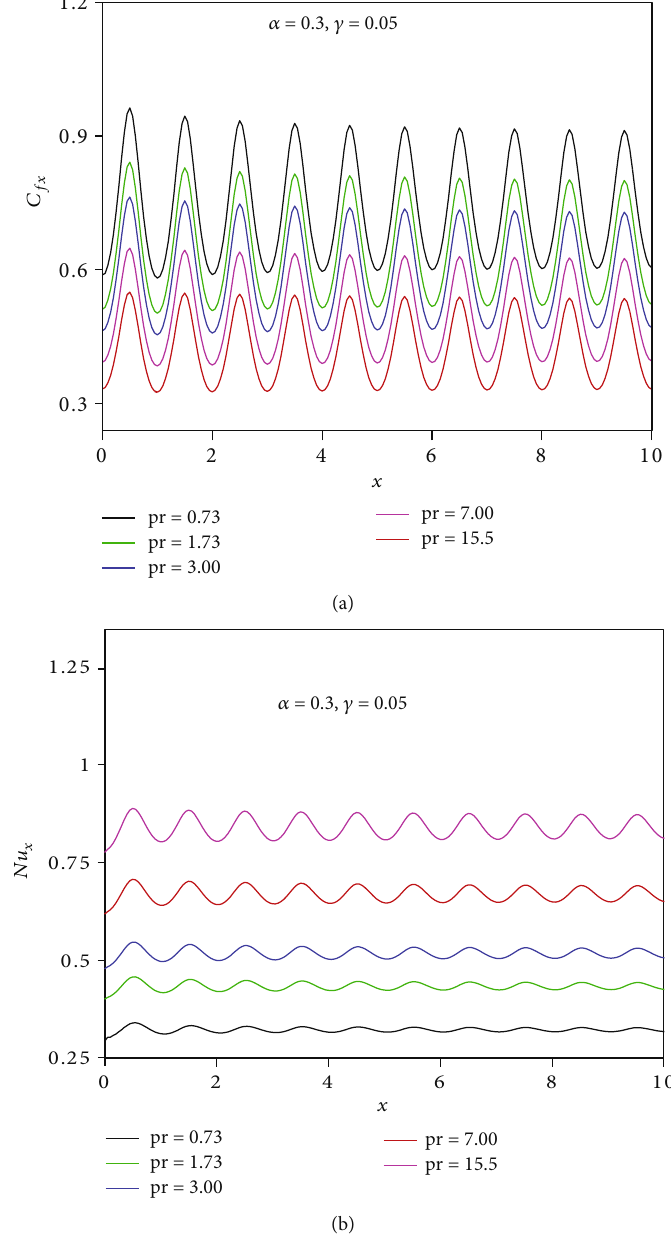
Figure 6: Variety of (a) skin friction coe ffi cient ( C Prandtl numbers while γ = 0 : 05 and α = 0 : 3 (see